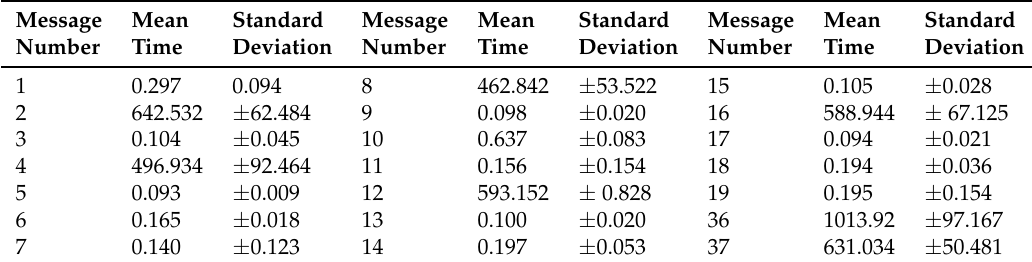
Table 3. Device authentication performance by messages.